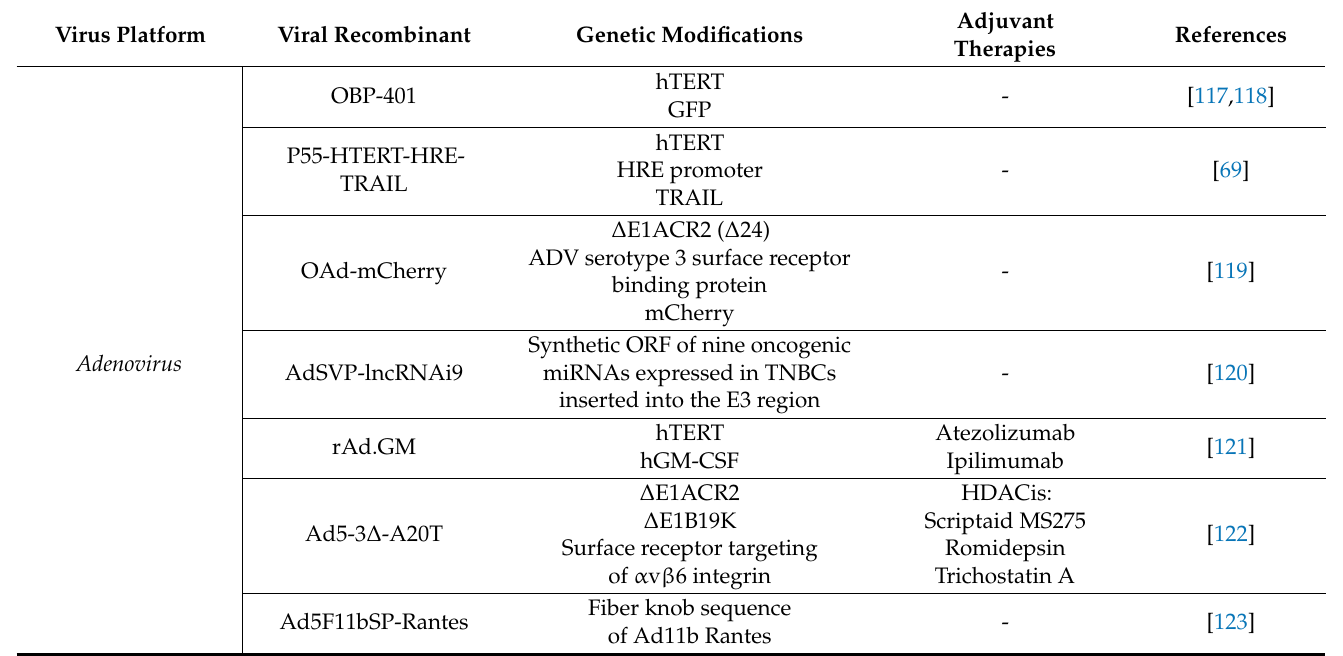
Table 1. DNA oncolytic viruses preclinically tested in vitro and in vivo against TNBC. Virus